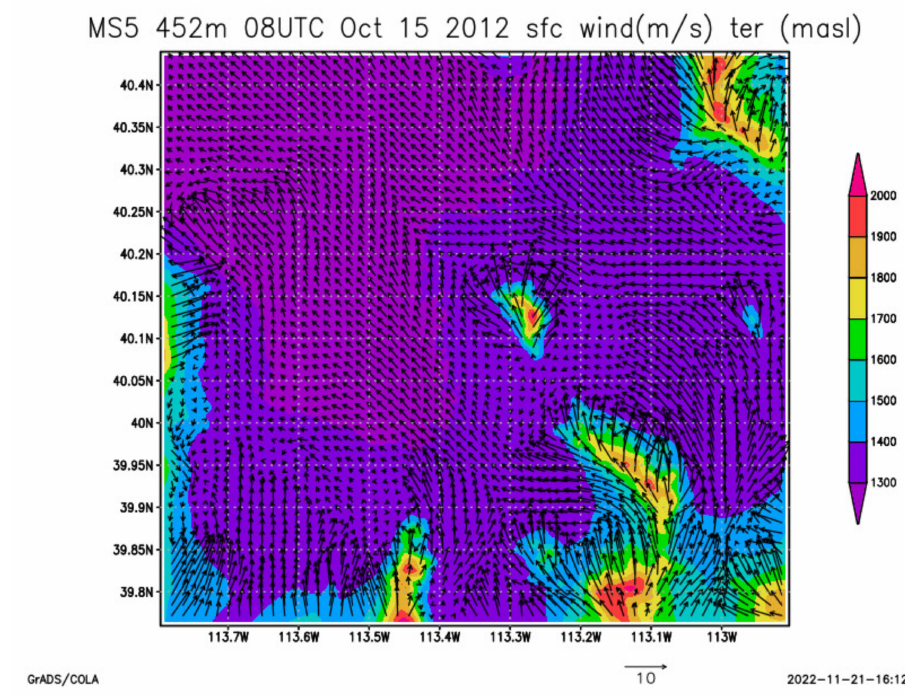
Figure 13. Model MS5 surface 10 m AGL wind vectors (m/s) for nest 4 (0.452 km), plotted over the model terrain (m ASL), valid at 0800 UTC 10-15-2012.